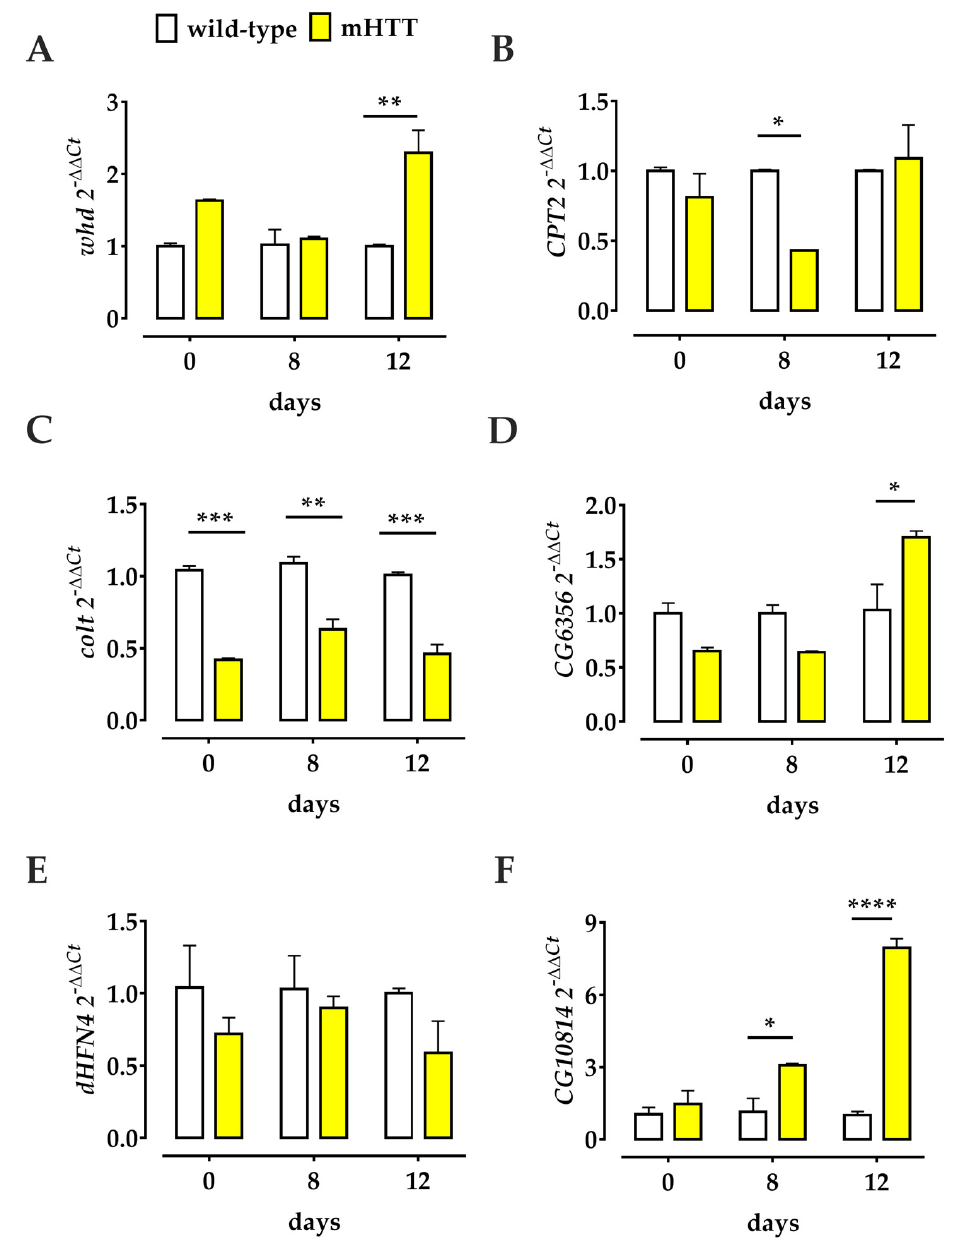
Figure 4. Altered transcriptional profiles in the heads of Q128HD-FL flies. Comparison of the relative gene expression of whd ( A ), CPT2 ( B ), colt ( C ), CG6356 ( D ), dHFN4 ( E ), and CG10814 ( F ) genes in 1-, 8-, 12-days old mHTT and age-matched wt flies. All CS component genes are affected by the HTT mutation: whd is overexpressed, while CPT2 and colt are both downregulated in the heads of Q128HD-FL flies compared to the wt. The hypothetical carnitine transporter CG6356 is overexpressed in the Huntington model in comparison to the wt. The master regulator of lipid oxidation dHNF4 remains unchanged at each time point examined. CG10814 , which encodes a carnitine biosynthetic enzyme was gradually over-expressed as the disease progresses in comparison to healthy wt flies. Relative gene expression was calculated with respect to the rp49 gene and control samples. (q)RT-PCR was performed on three different experiments, and the results are expressed as the mean of the values obtained (mean ± SEM). Sidak’s one-way ANOVA pairwise multiple comparisons test was used to calculate significance. * p < 0.05; ** p < 0.01; *** p < 0.001; **** p < 0.0001.